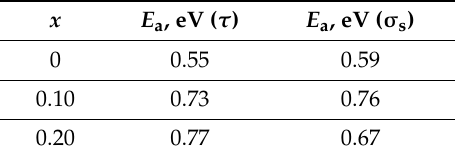
Figure 4. ( a , d , g )—The dependencies of ε ’/ ε 0 and ε ’’/ ε 0 of Bi 1 − x Er x FeO 3 ceramic samples with x = 0, 0.10, 0.20, respectively, on frequency ω . ( b , e , h )—Cole–Cole plots of Bi 1 − x Er x FeO 3 ceramic samples with x = 0, 0.10, 0.20, respectively. ( c , f , i )—Arrhenius plots of relaxation times τ and reach-through conductivity σ s of Bi 1 − x Er x FeO 3 ceramic samples with x = 0, 0.10, 0.20, respectively (Arrows show the increase in the temperature). Table 1. Activation energy of relaxation processes (in the case of x = 0—low-frequency process) and reach-through conductivity σ s of Bi 1- x Er x FeO 3 ceramic samples with x = 0, 0.10, 0.20, respectively, calculated by the Arrhenius law.